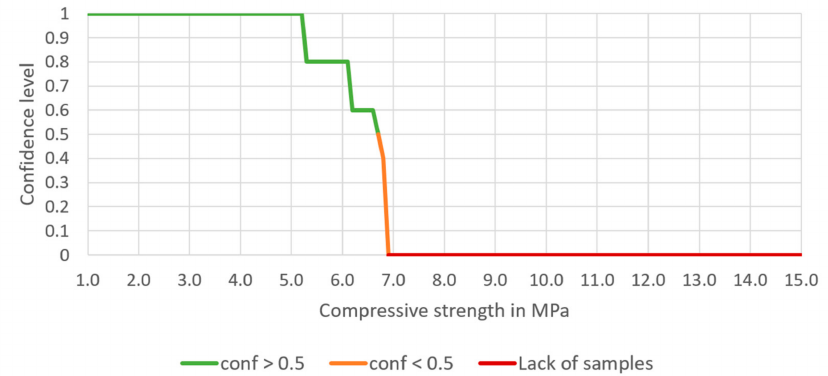
Figure 9. The dependence of the confidence of the rule on the chosen compressive strength, based on selected aggregate mixture and 6% cement content, and 11% water content, and 2100 ± 50 kg/m 3 density of